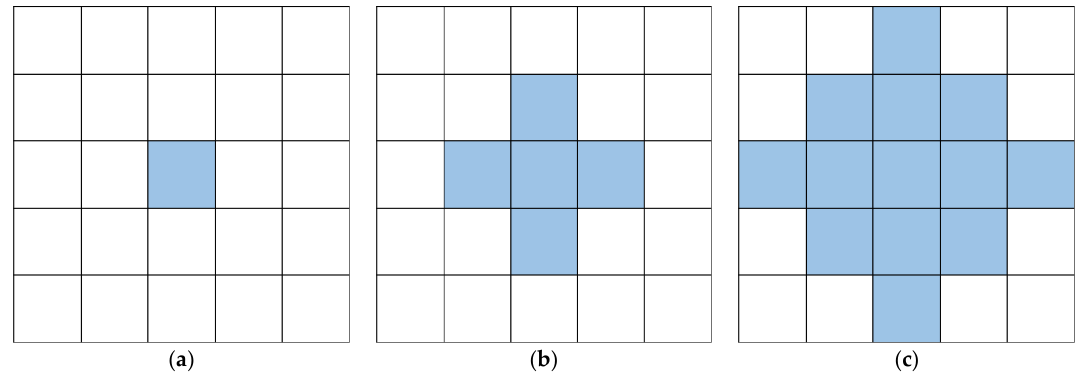
Figure 4. Various patterns of the outbreak cluster. ( a ) Type 1: small cluster; ( b ) Type 2: medium cluster; ( c ) Type 3: large cluster. ( c ) Type 3: large